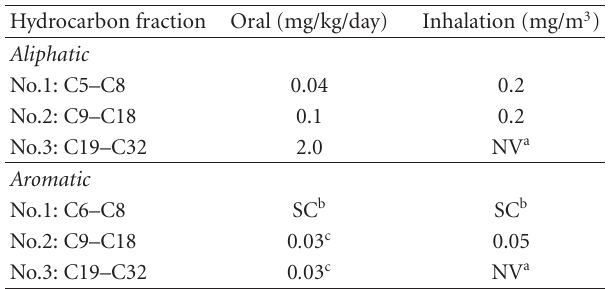
Table 1: MADEP toxicity values for TPH fractions [3]. Hydrocarbon fraction Oral